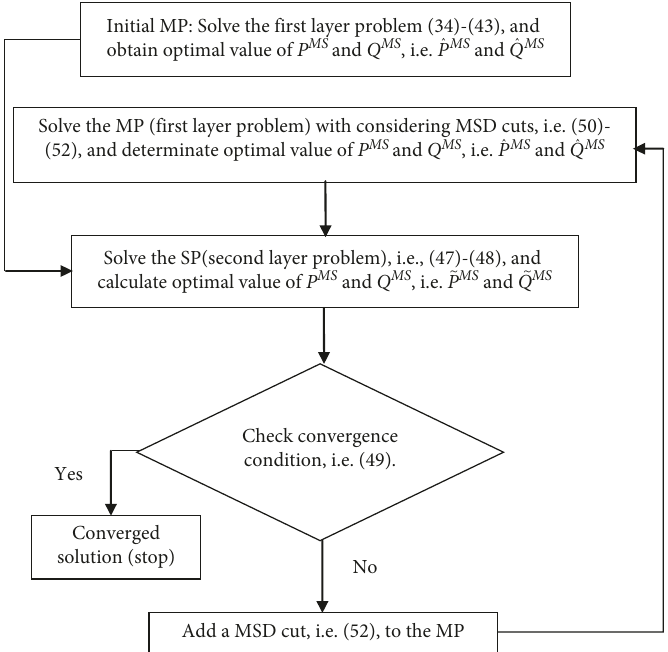
Figure 3: MSD flowchart to solve the proposed problem.